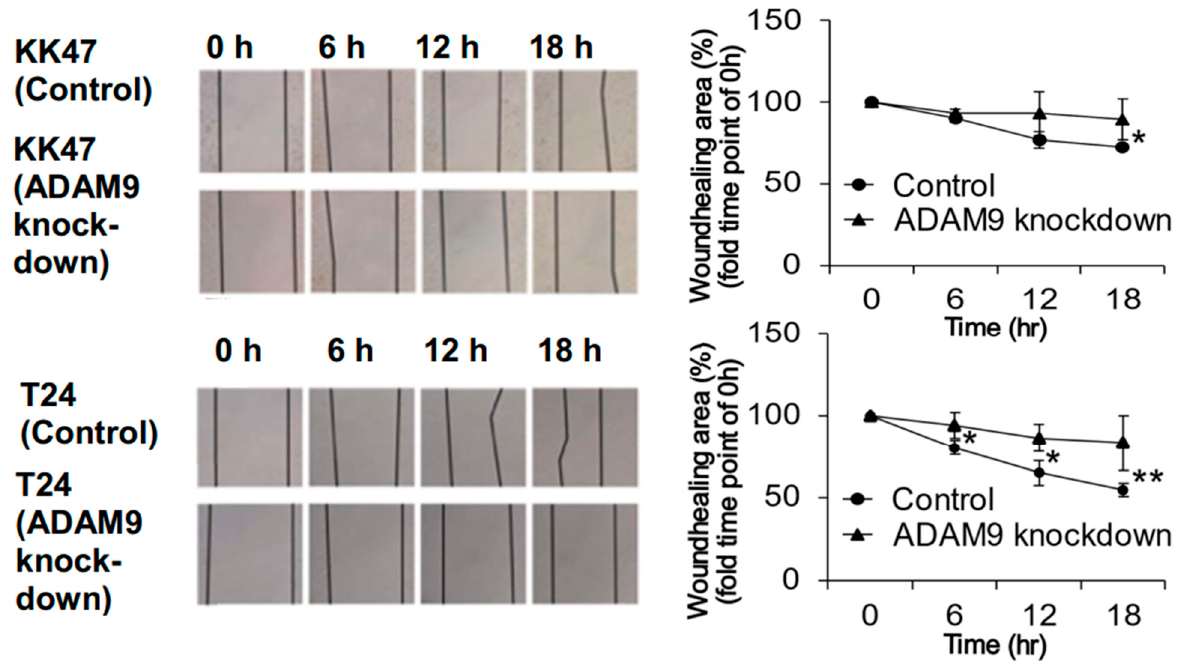
Figure 4. Wound-healing assay in control and ADAM9 knockdown cell lines. Migration ability was investigated in control and ADAM9 knockdown KK47 and T24 cell lines (400×) at 0, 6, 12, and 18 h. Wound area was quantified using ImageJ. ADAM9 knockdown significantly inhibited migration in KK47 cells after 18 h treatment ( p < 0.05) and in T24 cells after 6, 12, and 18 h treatment ( p < 0.05) (* p < 0.05, ** p < 0.01).